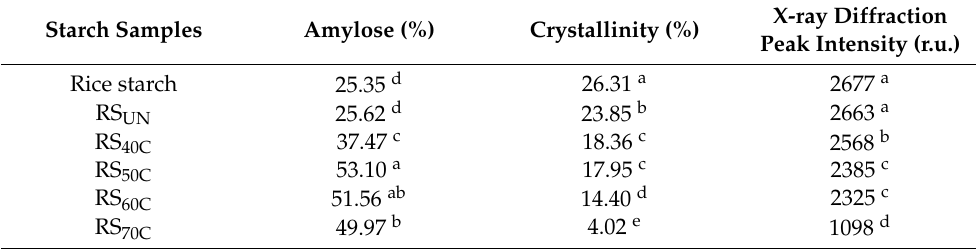
Table 2. Amylose content and degree of crystallinity (%) of native rice starch and resistant starches (RS) isolated from rice bran that was untreated and sonicated at different temperatures. X-ray Diffraction Starch Samples Amylose (%) Crystallinity (%) Peak Intensity (r.u.) Rice starch 25.35 d 26.31 a 2677 a RS UN 25.62 d 23.85 b 2663 a RS 40C 37.47 c 18.36 c 2568 b RS 50C 53.10 a 17.95 c 2385 c RS 60C 51.56 ab 14.40 d 2325 c RS 70C 49.97 b 4.02 e 1098